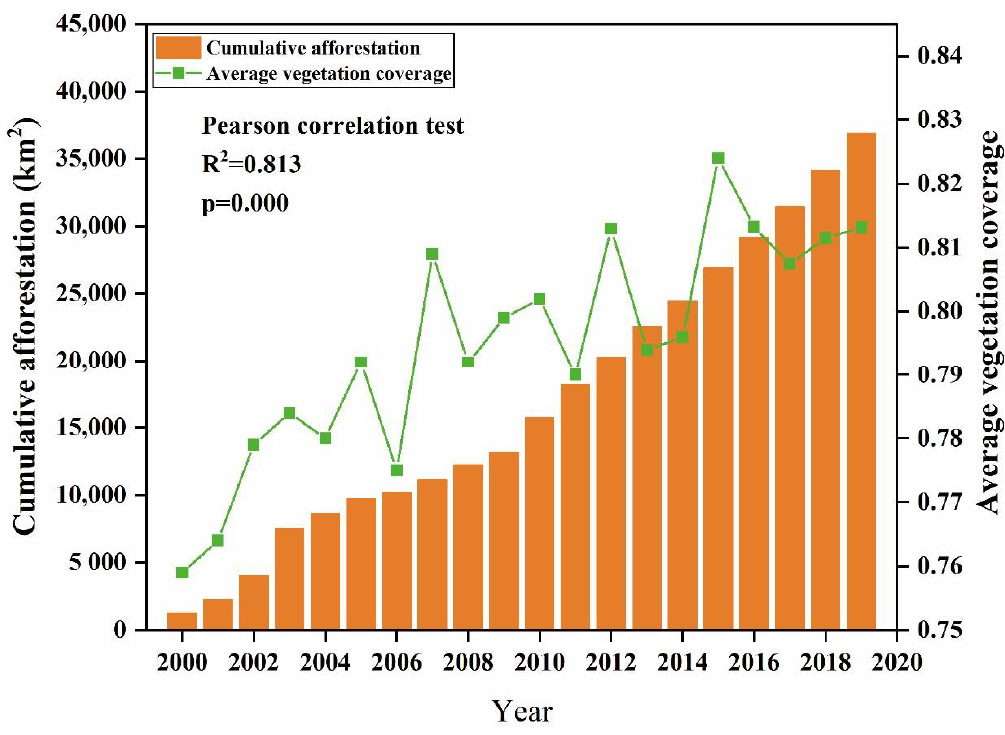
Figure 12. Correlation between cumulative afforestation area and average vegetation cover. Table 8. Area and proportion of afforestation in Chongqing in different time periods. Table 9. Area of afforestation for two key ecological projects related to